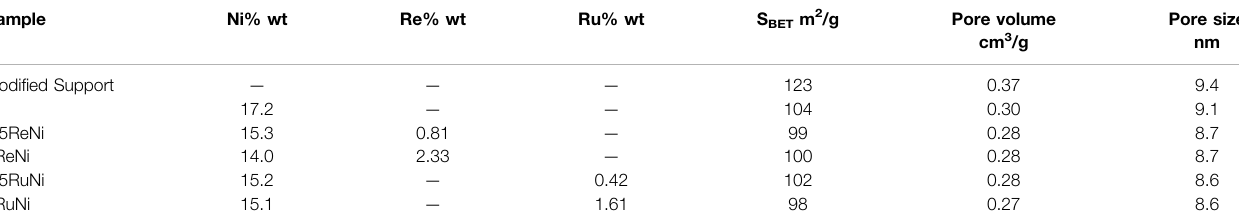
TABLE 1 | Textural properties and composition of the synthesized samples. Sample